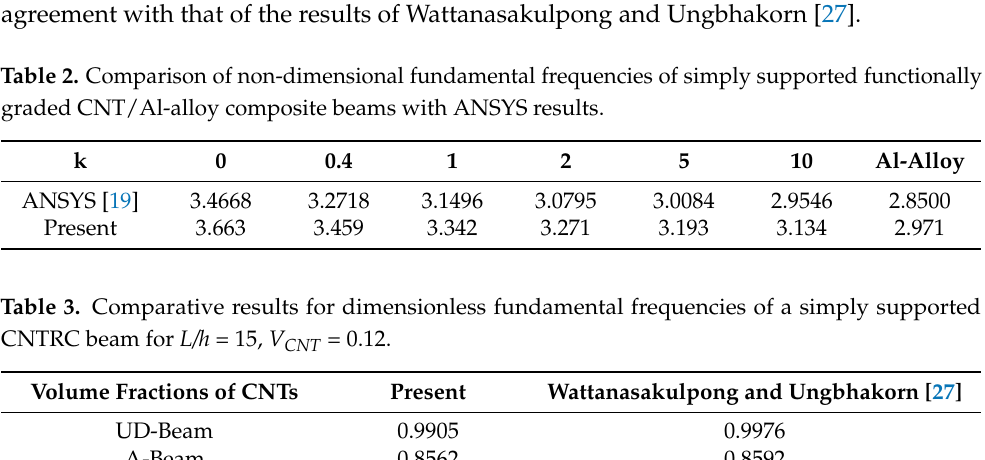
Figure 3. Time responses of the CNTRC beam with different reinforcement patterns for V CNT = 0.17.